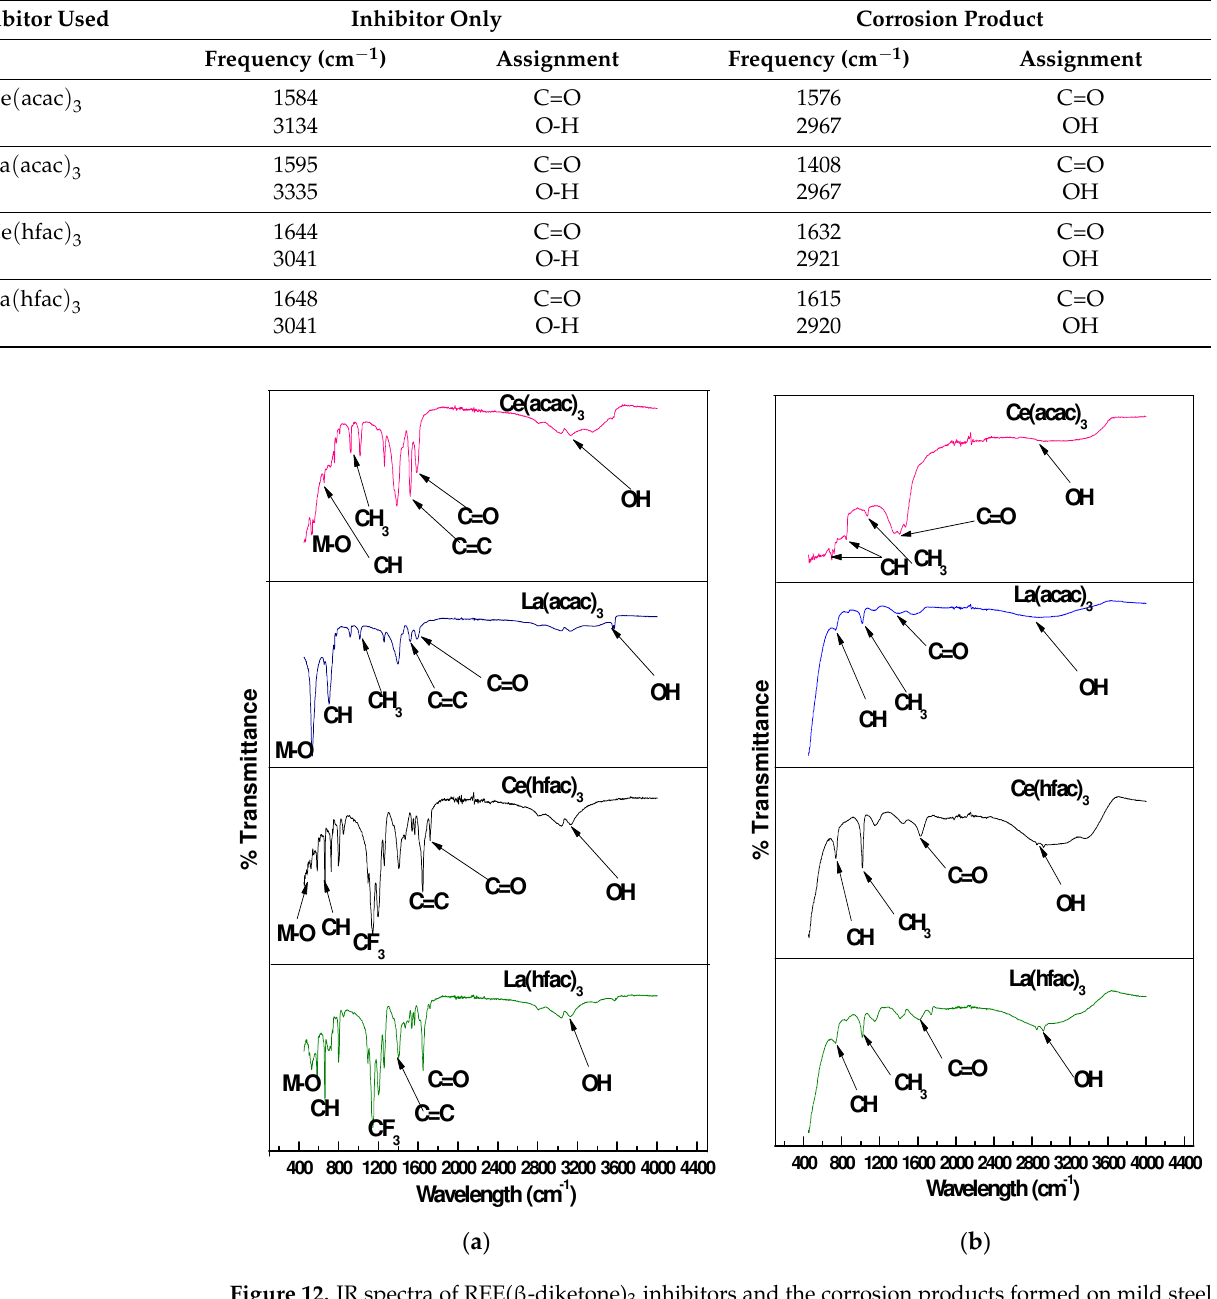
Table 5. IR frequency bands of REE( β -diketone) 3 inhibitors and the corrosion products formed on mild steel and 304 stainless steel.